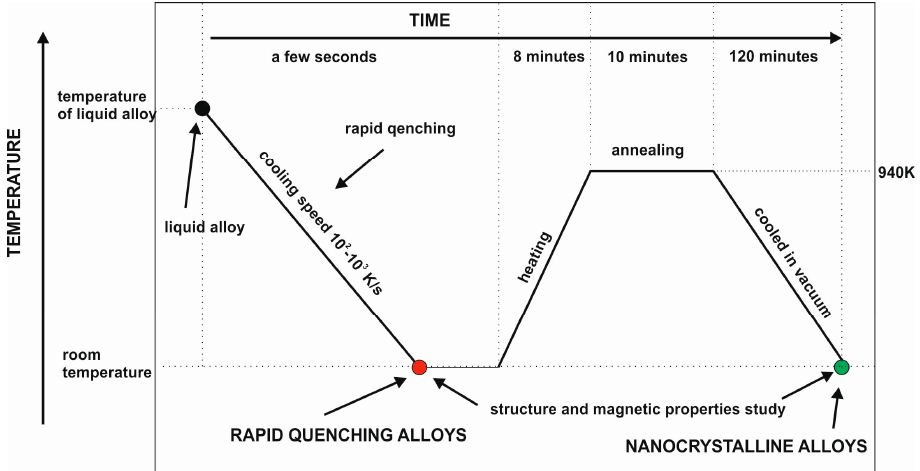
Figure 1. Thermal diagram of tested alloys.